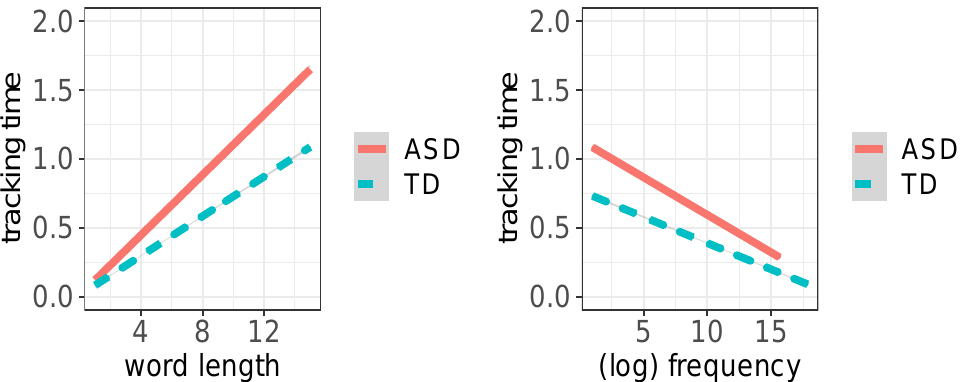
Figure 5. Linear regression plot for word length ( left ) and word frequency ( right ) for both ASD and TD children (plot obtained with the ggplot2 package, function lm